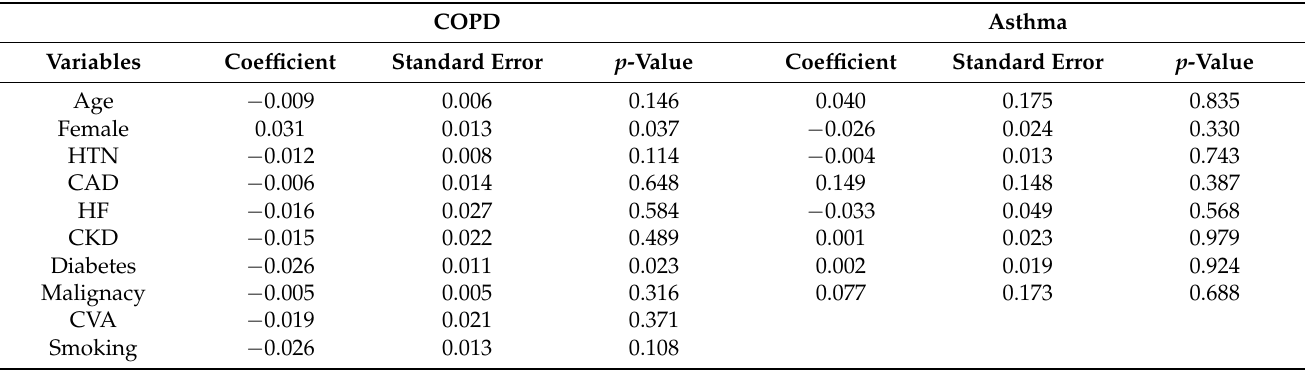
Table 3. Results of the meta-regression